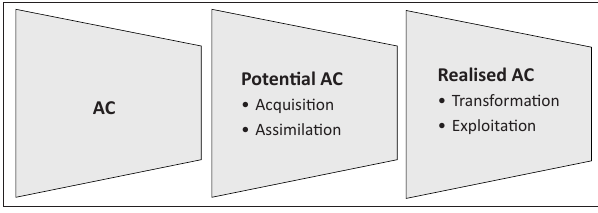
FIGURE 1: Absorptive Capacity Construct.